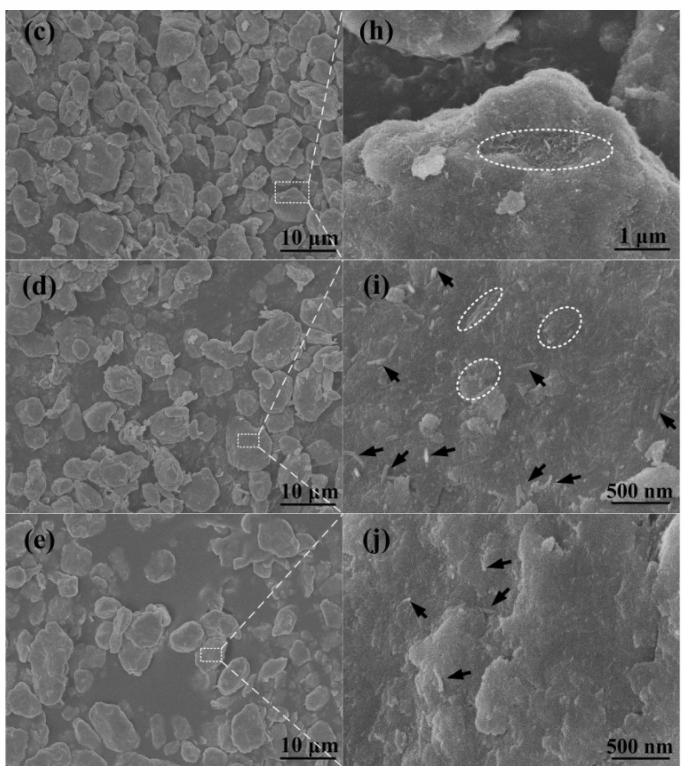
Figure 4. FESEM micrographs of CNT/Al (with powder size of 5 µ m) mixture ball milled for ( a ) 3 h, ( b ) 6 h, ( c ) 12 h, ( d ) 18 h and ( e ) 24 h. From ( f ) to ( j ) are the magnified images of the white dotted regions in ( a – e ),